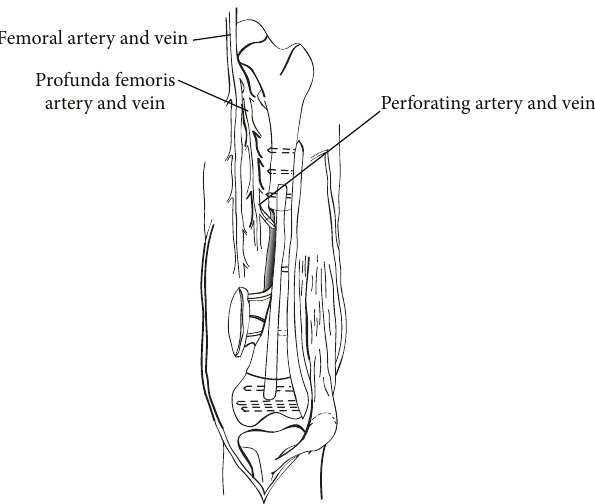
Figure 1: Illustration showing reconstruction of a femur diaphysis using a composite graft with a devitalized autograft and a vascular- ized fibula